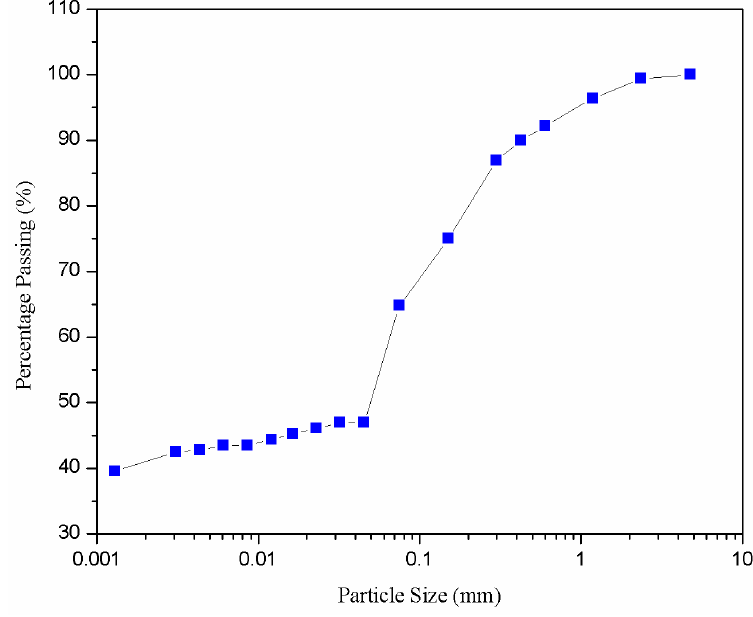
Figure 1. Particle size distribution curve of the natural soil.